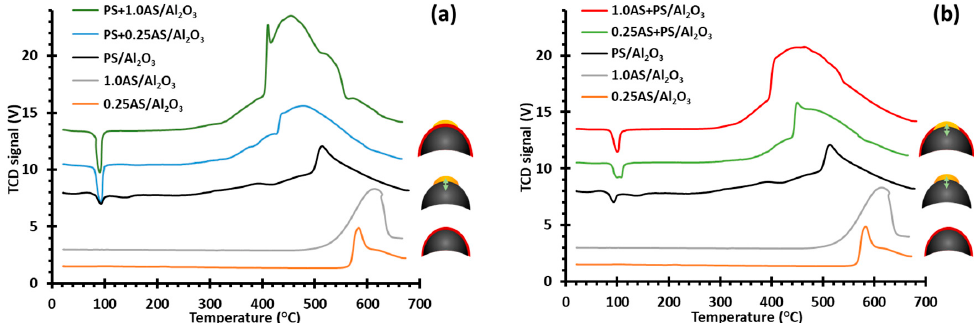
Figure 3. Thermal decomposition under hydrogen gas of ( a ) alumina ‐ supported combined sulfates PdSO 4 (PS) + 0.25 Al 2 (SO 4 ) 3 (AS)/Al 2 O 3 and PS + 1.0 AS/Al 2 O 3 , and ( b ) alumina ‐ supported combined sulfates 0.25 AS + PS/Al 2 O 3 and 1.0 AS + PS/Al 2 O 3 together with individual alumina ‐ supported sulfates PS/Al 2 O 3 , 0.25 AS/Al 2 O 3 and 1.0 AS/Al 2 O 3 . Experiments were carried out under 10% H 2 in an argon gas atmosphere.